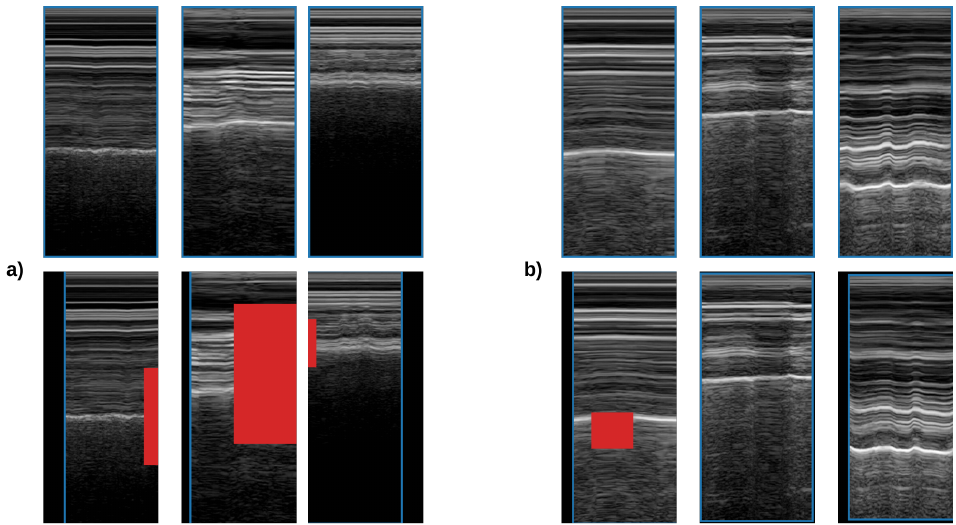
Figure 5. Dataset augmentation for M-mode classification. In the top row, we can observe original samples from the dataset, and in the bottom row, we can see augmented samples. Blue outlines the original image. Red represents randomly erased areas. ( a ) Examples of lung sliding presence; ( b ) examples of lung sliding